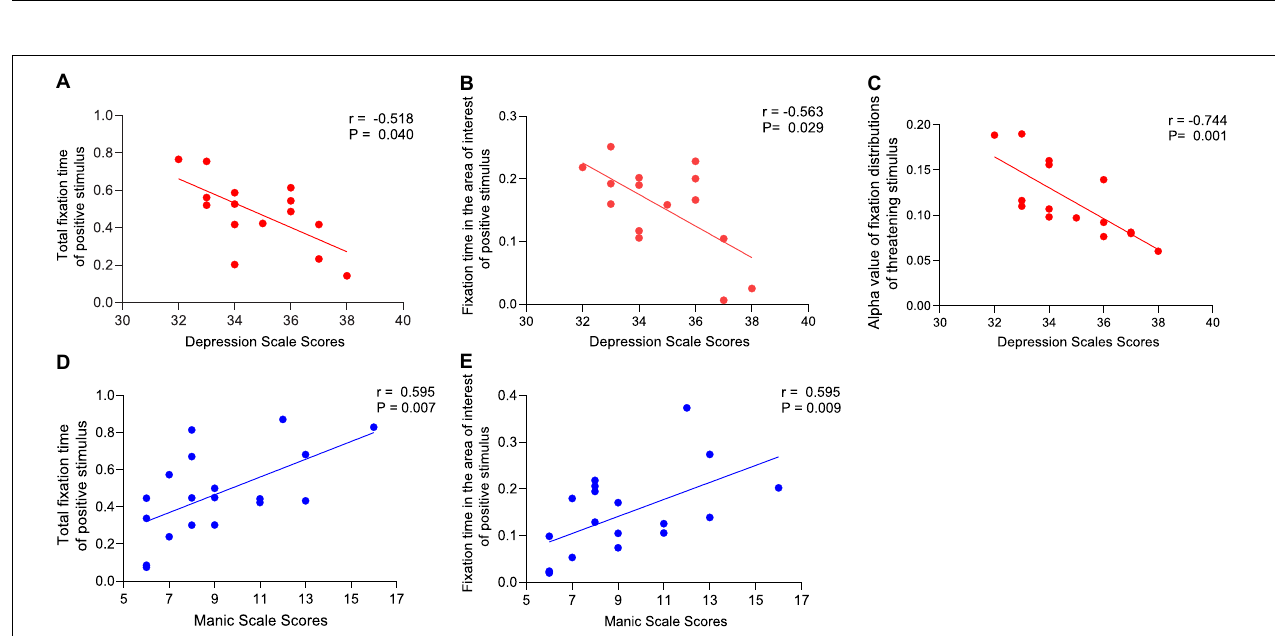
FIGURE 3 | Grand averaged waveforms of mean electrodes for different emotional stimuli. The comparison of the three groups regarding N100 components in (A) positive stimulus type, (B) dysphoric stimulus type, (C) threatening stimulus type, and (D) neutral stimulus type. Odd numbers represent electrode locations on the left hemisphere, whereas even numbers represent those on the right hemisphere.